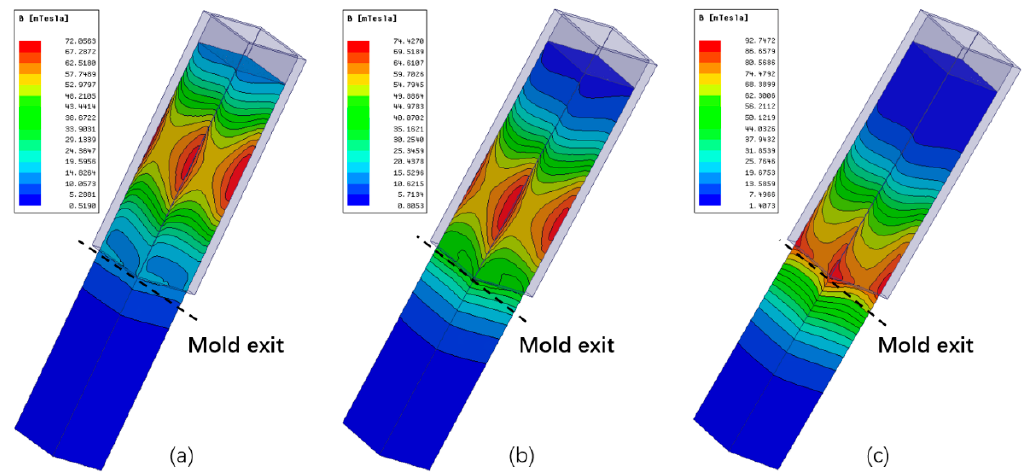
Figure 14. Contour plot of magnetic flux density on the strand surface under different stirrer installation positions at 500 A/3 Hz: ( a ) Case A; ( b ) Case B; ( c ) Case C.